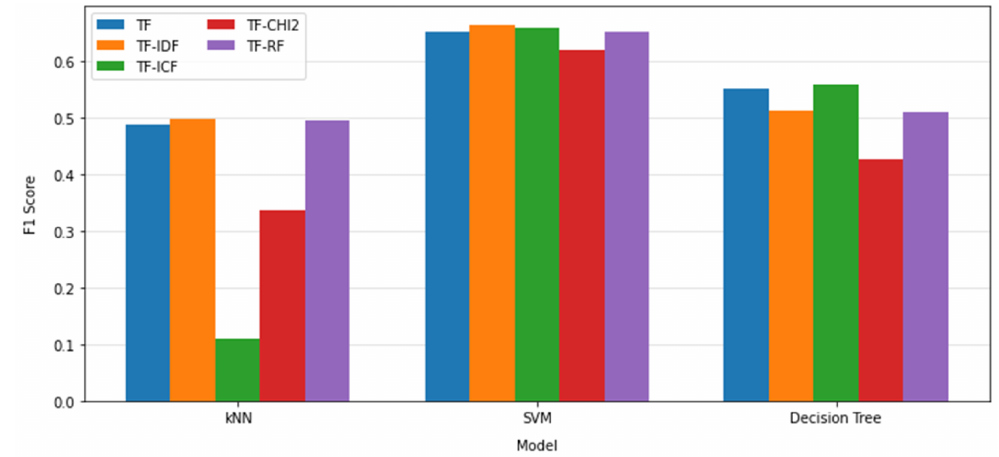
Fig. 6 The result of the F1 score for each term-weighting scheme using a combination of uni-gram, bi-gram, and